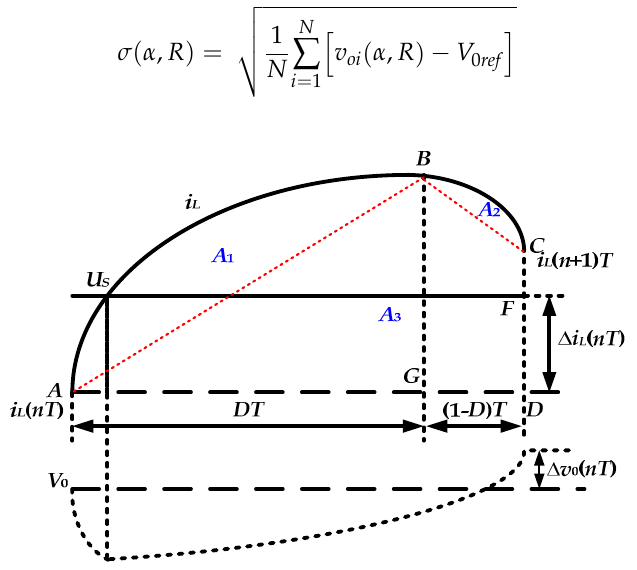
Figure 6. The waveforms of winding current and output voltage during a switching cycle.